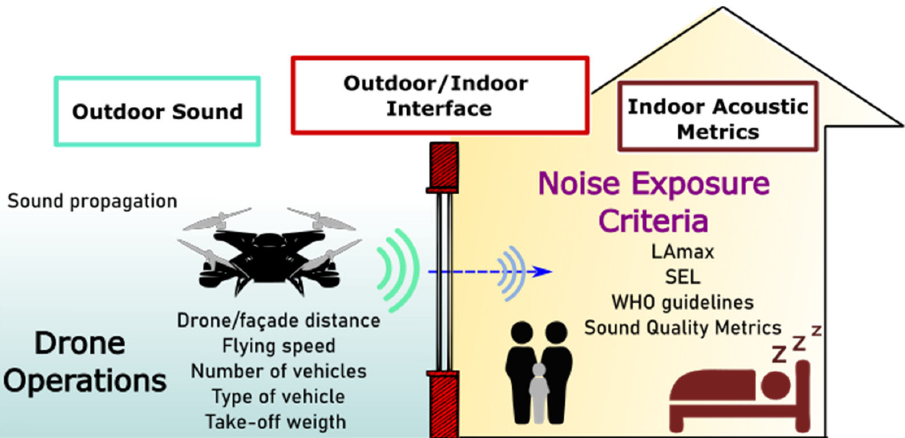
Figure 1. Framework for drone operating recommendations based on acoustic metrics analysis.